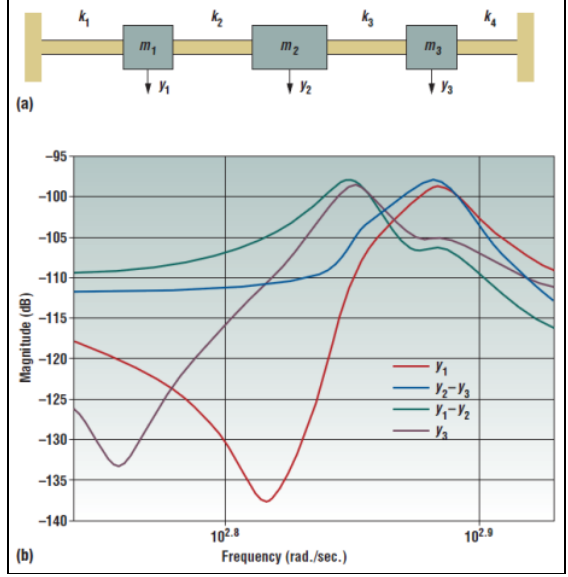
Figure 21. Multimass harvesting system ( © 2005 IEEE. Reprinted with permission from [47]).